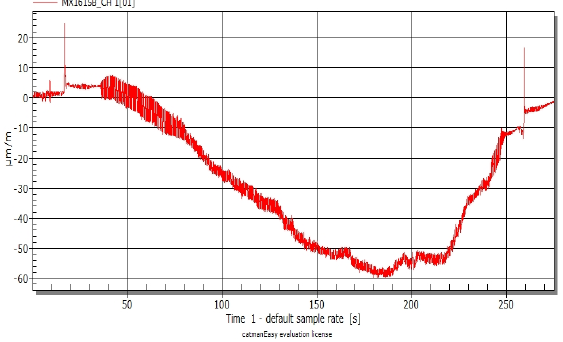
Figure 22. Measurement of strain for increase in throttle.